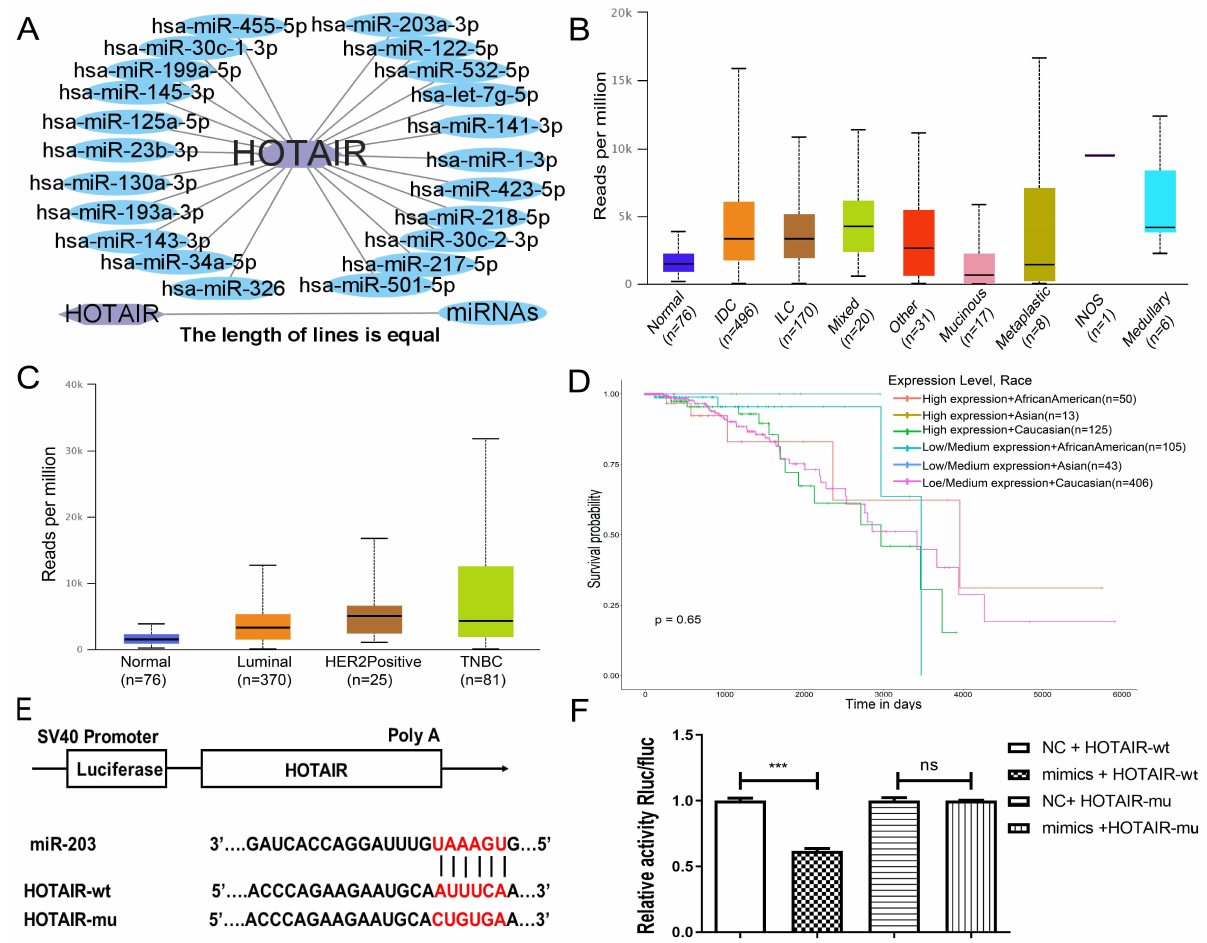
Figure 3. miR-203 functions in cancer, and HOTAIR acts as a molecular sponge for miR-203 . ( A ) Data of possible HOTAIR -bound miRNAs were derived by comprehensive analyses of ENCORI and DAVID. The HOTAIR-miRNA network map was made by Cytoscape3.0 software. ( B ) Compared with normal tissues, miR-203 was overexpressed in breast invasive carcinoma through the UALCAN analysis of the TCGA database. ( C ) miR-203 was significantly overexpressed in luminal breast cancer, HER2 -positive breast cancer, and TNBC. ( D ) Breast cancer patients with high expression of miR-203 might have a poorer prognosis. ( E ) Putative complementary sites between HOTAIR and miR-203 . Mutations were generated in the HOTAIR nucleotides complementary to miR-203 . ( F ) Fluorescence expression was detected by the dual-luciferase reporter gene. Compared with the NC group, the luciferase activity of the miR-203 mimics/ HOTAIR -wt group decreased, while the luciferase activity of the miR-203 mimics/ HOTAIR -mu group did not change significantly ( p > 0.05). Values were significantly different compared with the corresponding control value at *** p < 0.001. ns > 0.05. K means 1000. IDC, invasive ductal carcinoma; ILC, invasive lobular carcinoma; TNBC, triple-negative breast